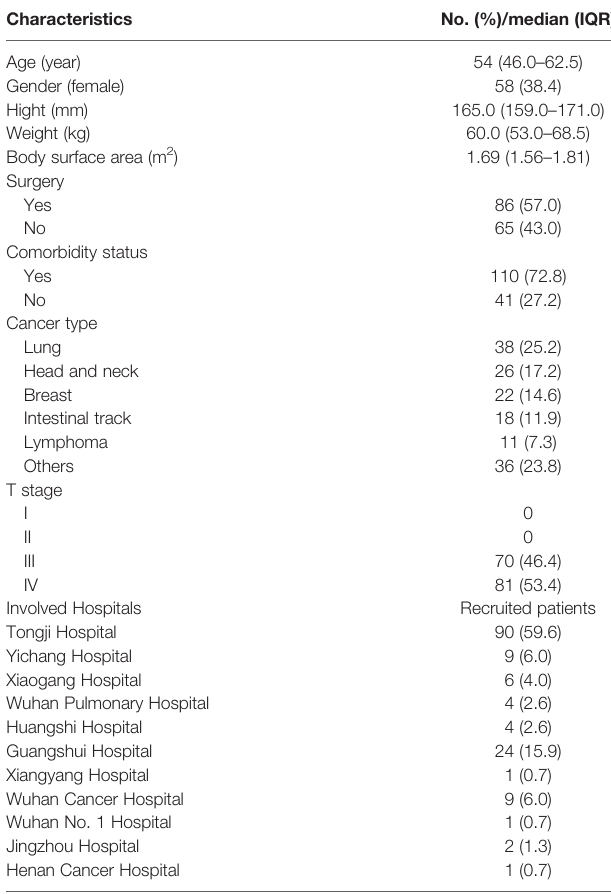
TABLE 1 | Patient and tumor characteristics and involved hospitals (N = 151).